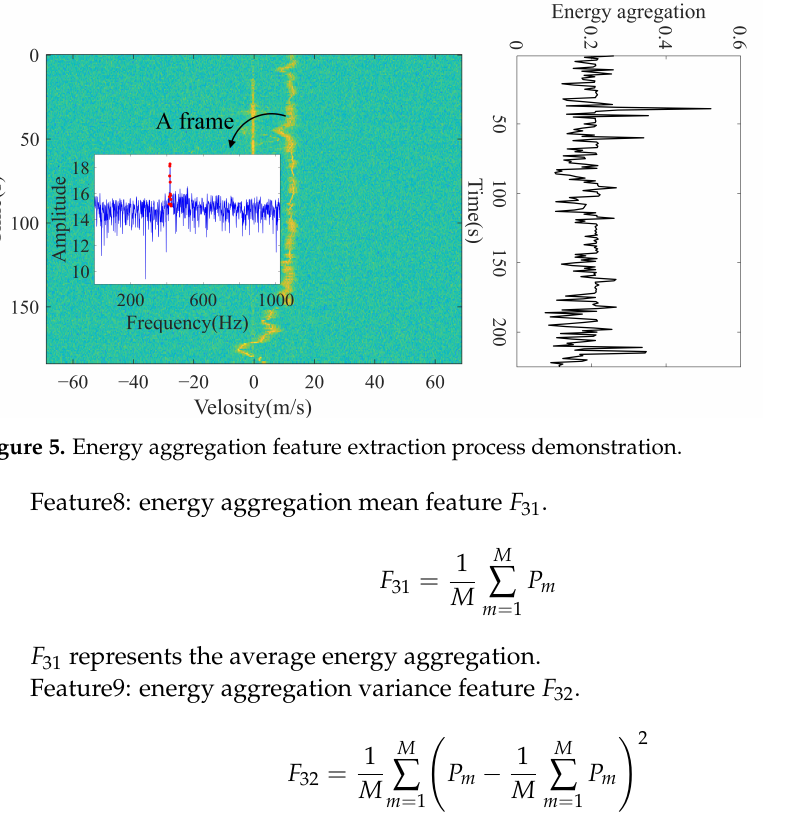
F 31 represents the average energy aggregation. Feature9: energy aggregation variance feature F 32